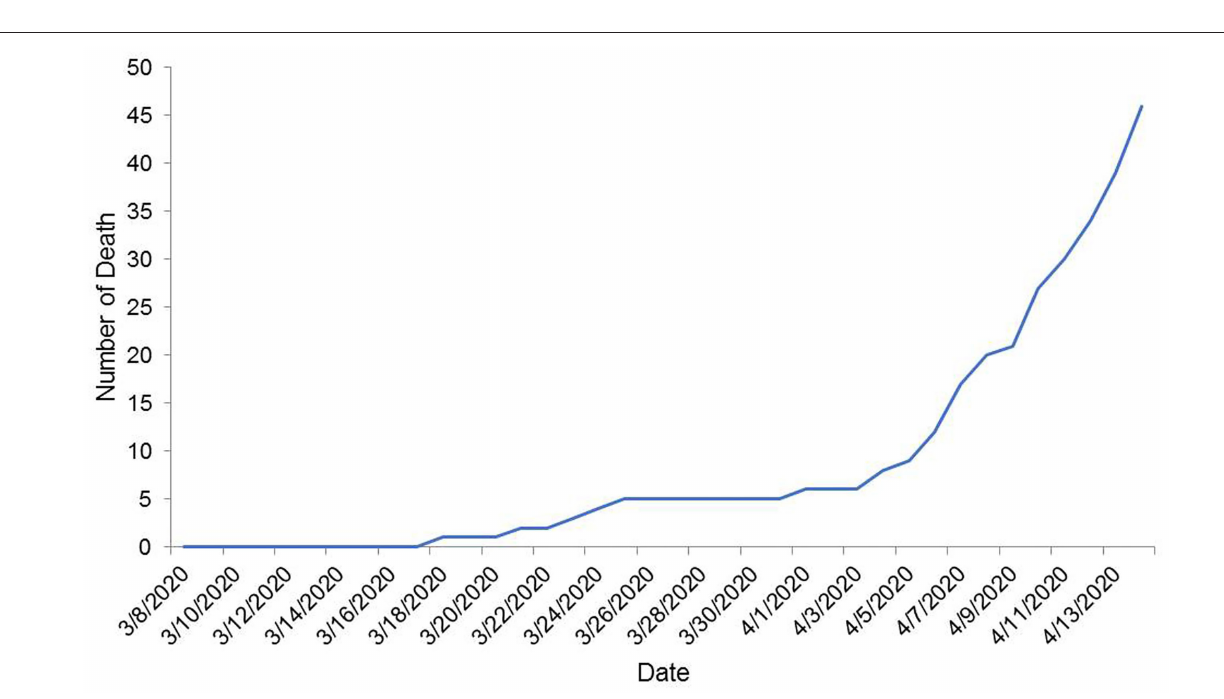
situation of social distancing among people in Bangladesh.